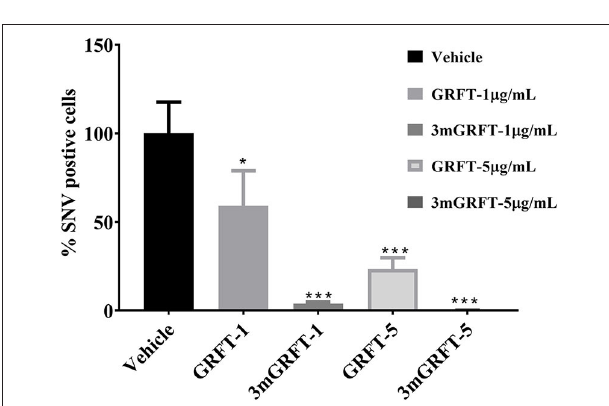
FIGURE 4 | Antiviral effects of GRFT and 3mGRFT on Sin Nombre virus replication. Vero-E6 cells were treated for 1h with either 1 or 5 µ g/mL of GRFT or 3mGRFT before infection with Sin Nombre virus (SNV) at MOI of 0.2. At 72h post infection, the cells were fixed, permeabilized, and stained with an antibody against Puumala virus nucleoprotein that cross-reacts with SNV nucleoprotein. Dose-response curve showing the quantitation of SNV-infected cells treated with GRFT or 3mGRFT (% normalized to vehicle-only controls). Graphs represent the mean ± SD and are representative of three independent experiments, performed in quadruplicate. P * < 0.05, P *** <